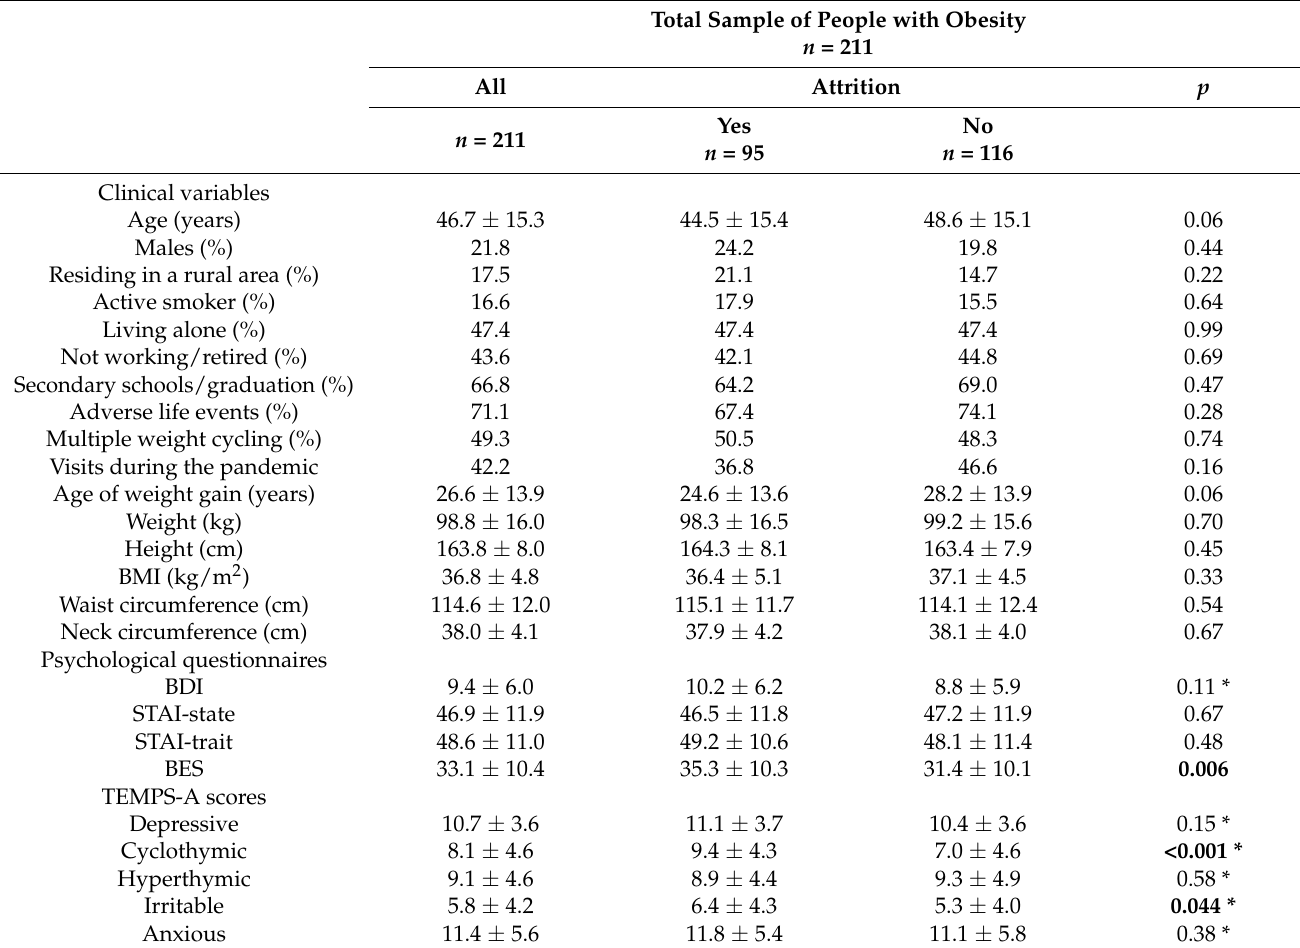
Table 1. Characteristics of the whole cohort and by the risk of attrition. Total Sample of People with